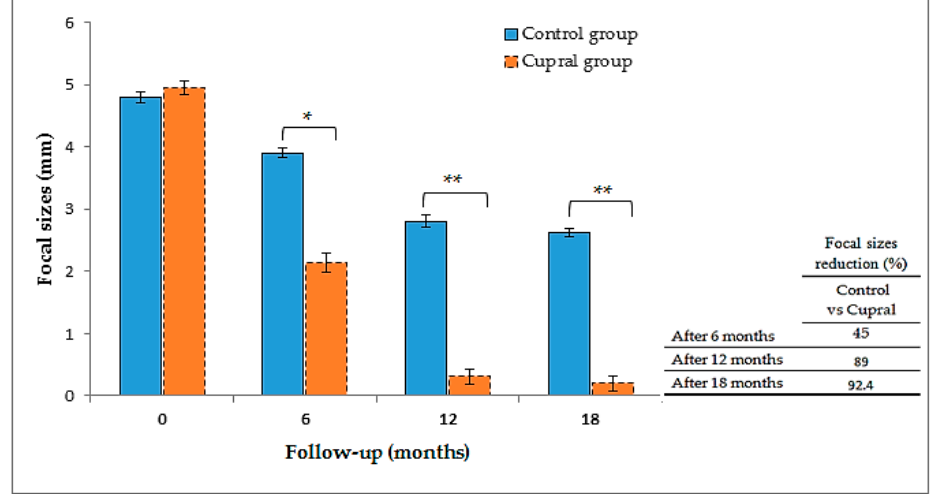
Figure 3. Measurements of focal sizes and drastic reduction upon Cupral-electrophoresis treatment. The focal sizes values (mean ± SEM of focal measures in mm) are represented by the columns at time 0 and during the follow-up in months. The focal sizes reduction (%) related to each condition is shown in the right insert. Statistical analysis was performed using the Student’s t -test; * p < 0.05, ** p < 0.01: control (traditional) vs. Cupral groups.